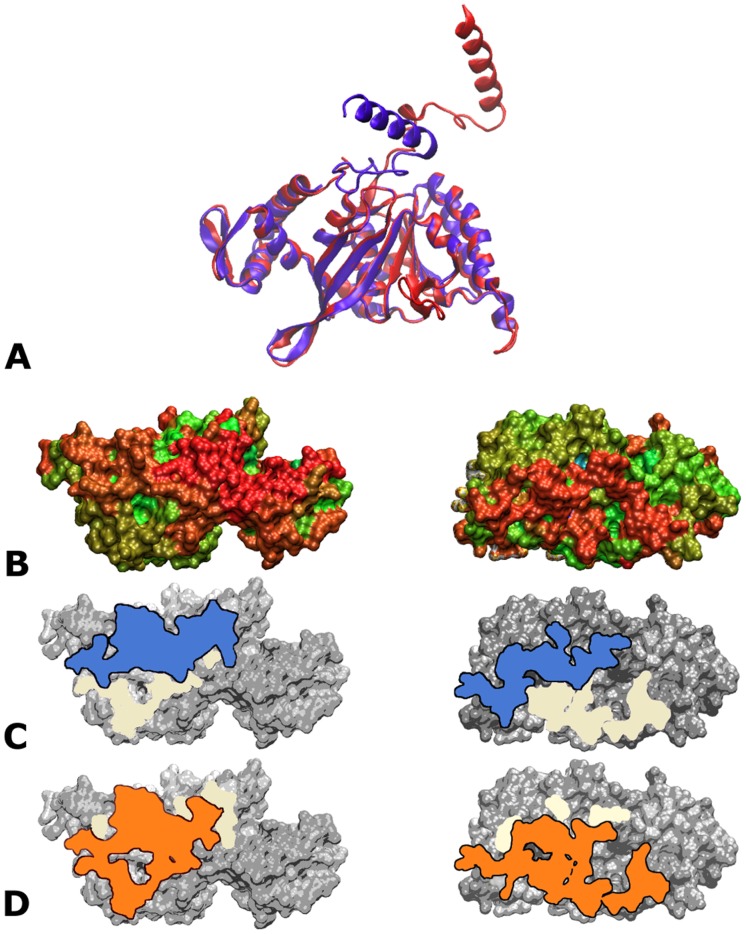
RecA-RecA docking.(A) Superposition of monomers taken from the 2REB (blue) and 3CMW (red) crystal structures, in cartoon representation; the rigid core is the region where the two structures are almost superimposable. (B-D) Binding regions on the surface of one RecA monomer, restricted to its rigid core. The left side shows the top of the monomer, the right side the bottom. (Note: orientations are chosen to best show the interacting surface, and are not exactly 180∘ apart). (B-C) Interface patterns characterizing the X (B) and the X* (C) binding modes. In both panels B and C, the union of the two interfaces is shown in pale yellow, while the specific X or X* interface is overlaid in blue (B) or orange (C). (D) Each residue is colored according to the best interaction energy of the interfaces to which it belongs, normalized by the best interaction value found in the simulation. The color ranges from blue to red to indicate 0–100% of the maximum interaction value. The interaction energies result from merged docking simulations carried out using the 2REBcore or the 3CMWcore monomers (see Methods). The rigid core represented as a 3D support in all views is 2REBcore.